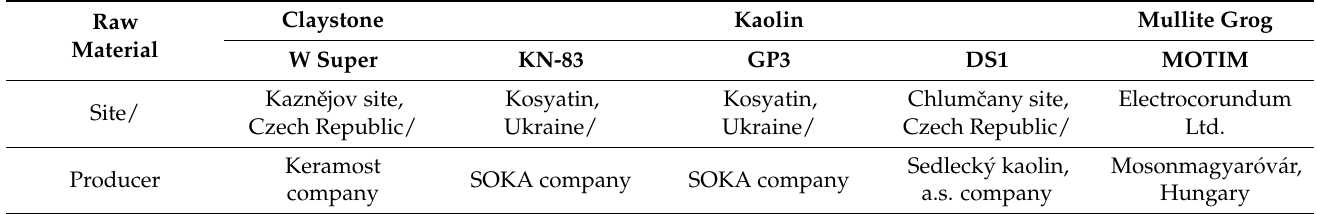
Table 1. List of raw